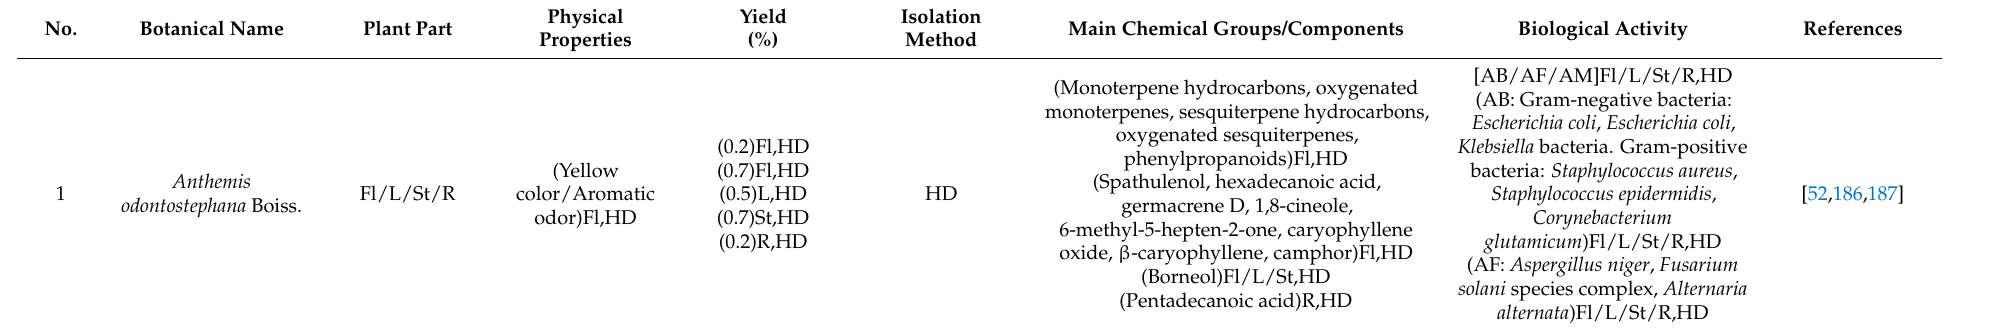
Table 8. Details of EOs isolated from species of